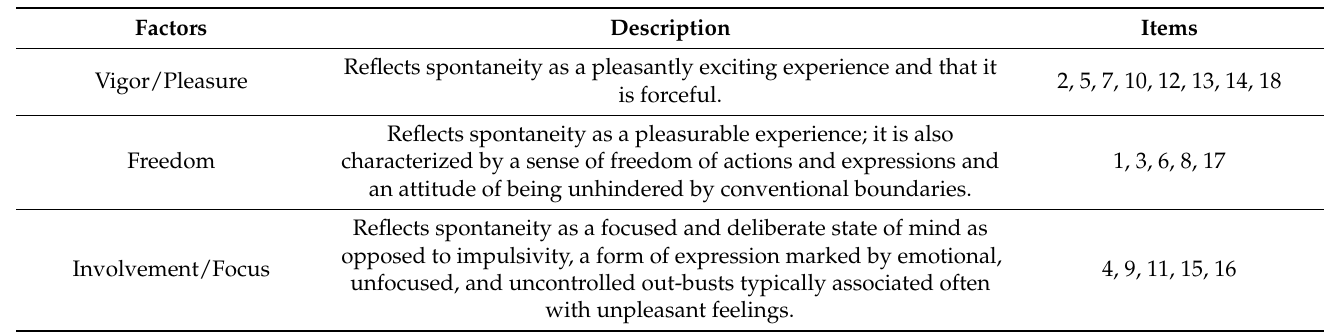
Table 1. Dimensions, description, and corresponding items from the original 3-factor version of the SAI-R (Kipper, & Beasley, 2016). Factors Description Items